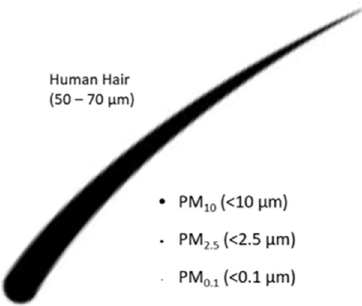
Figure 1. Illustration of the most important size classes of Particulate Matter (PM).